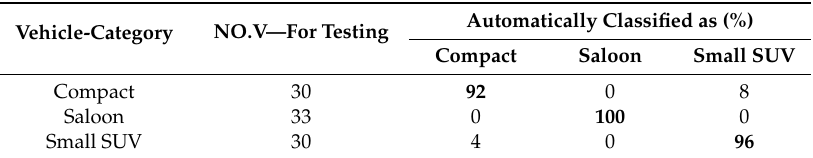
Figure 9. ( a ) Location of training data in PCA space; and ( b ) the spreading of testing data in the database of PC domain. Table 3. Vehicle category confusion matrix.